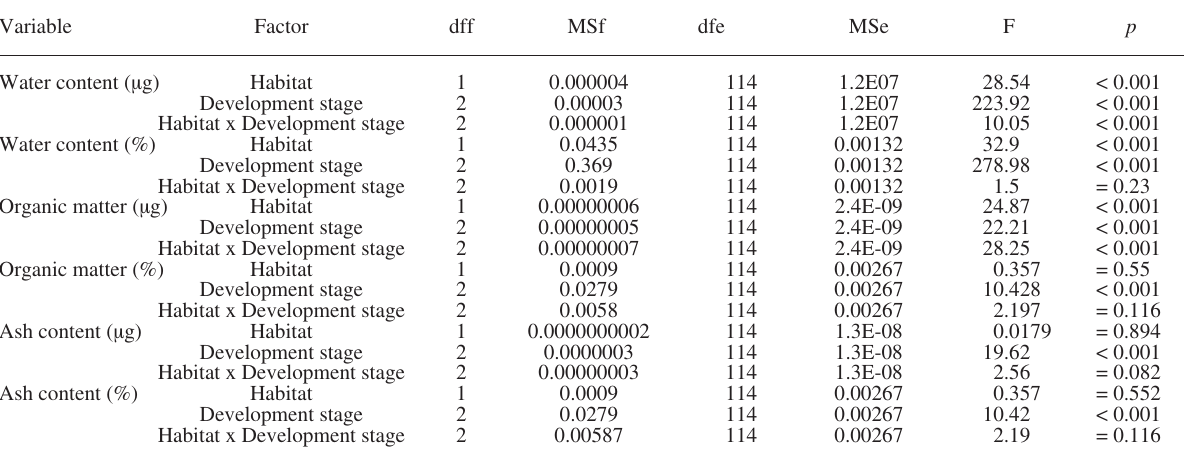
Table 5. – Neohelice granulata . Two-way anoVa evaluating differences in embryonic contents of water, organic matter, ash (expressed in µg and % of dW), comparing different stages of development (i, ii, iii) and habitats (mudflats vs saltmarshes). Symbols as in Table 4.